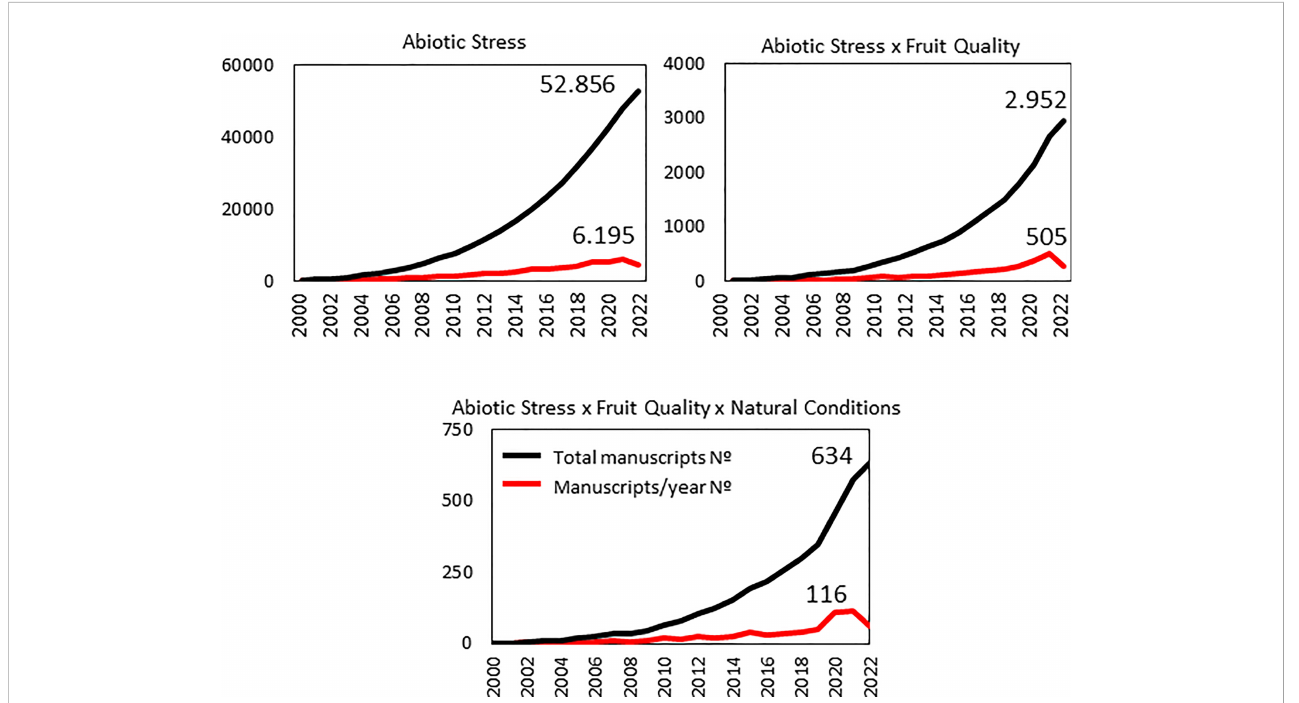
FIGURE 1 Number of manuscripts published between 2000 and 2022 years within the topics ‘ Abiotic stress ’ , ‘ Abiotic stress x Fruit quality ’ , and ‘ Abiotic stress x Fruit quality x Natural conditions ’ . Source: Web of Science. It is evident the important reduction of published articles for ‘ Abiotic stress x Fruit quality ’ , and still more when searching is restricted to ‘ Abiotic stress x Fruit quality x Natural conditions ’